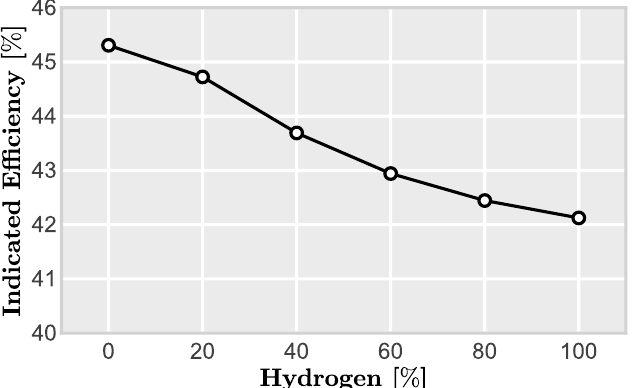
Figure 14. Indicated efficiency trends when the amount of hydrogen is increased in the fuel blend at λ =